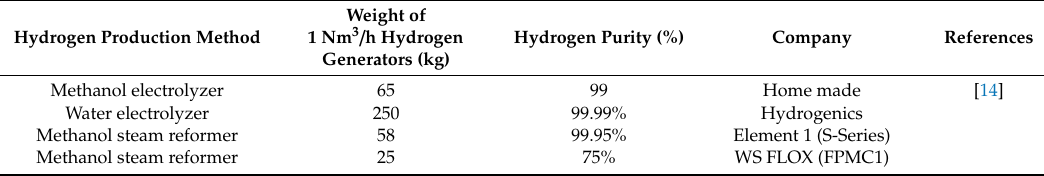
Table 3. Hydrogen generator weight